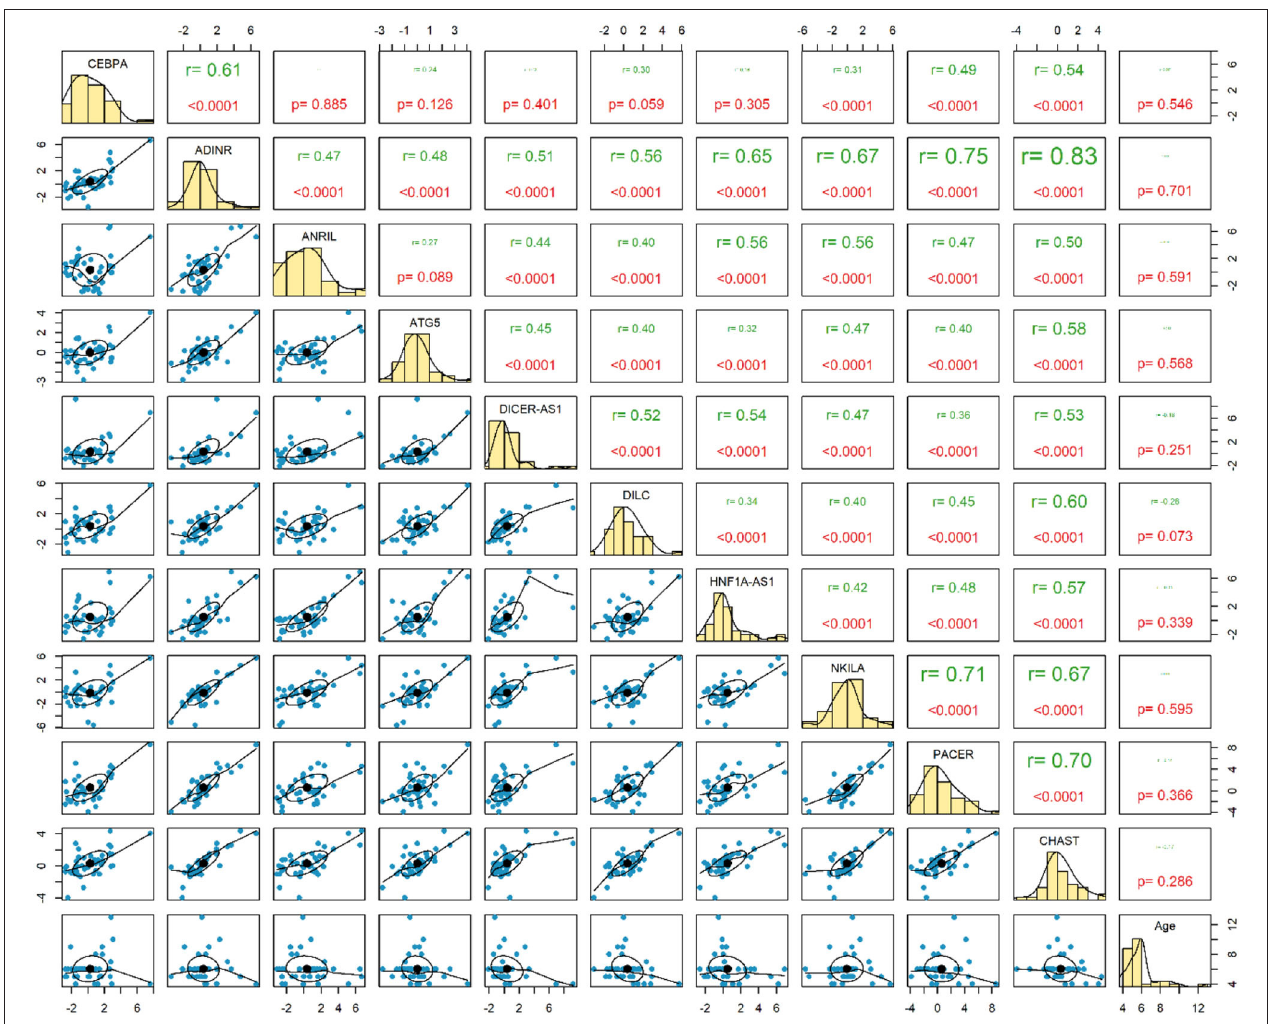
FIGURE 3 | Correlation between expressions of genes among healthy